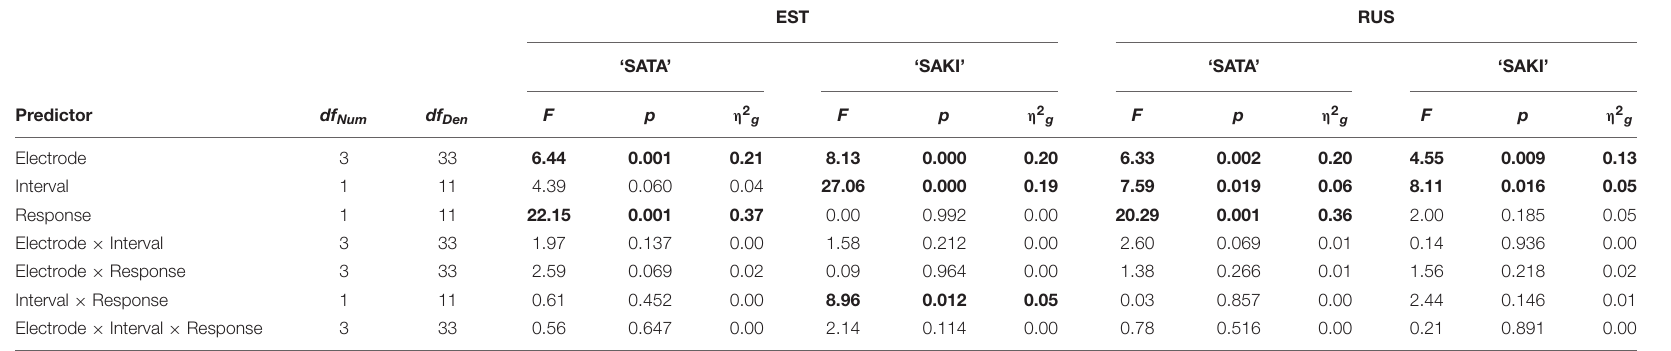
TABLE 8 | ANOVA results in the ‘Falling ST-Level DEV’ condition for each Language group (EST, RUS) and Word set (‘SATA,’ ‘SAKI’).